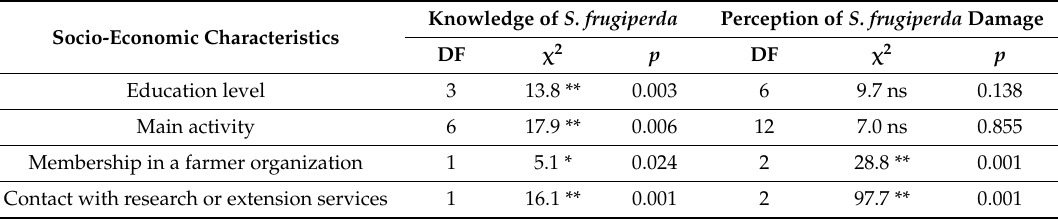
Table 4. Chi-square analysis of the relationships between knowledge of S. frugiperda , perception of damage, and socio-economic characteristics of farmers.